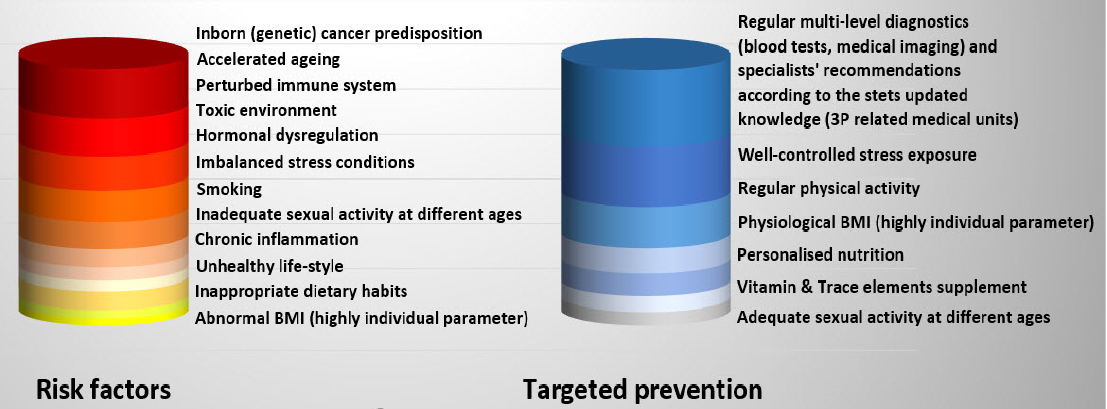
Figure 2. PCa-relevant risk assessment, individualised prediction and targeted prevention [3].